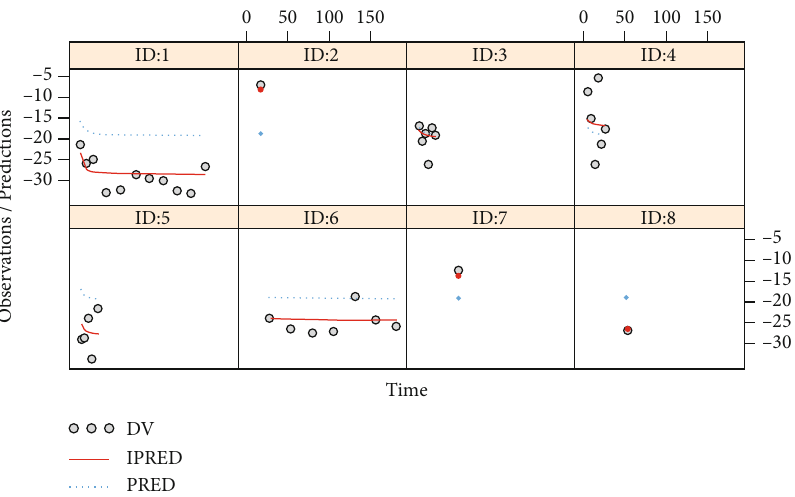
Figure 2: Individual plots. ID: 1-8 were from studies [16 – 21].